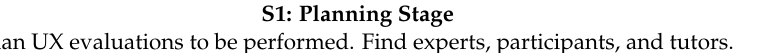
Table A1. Planning Stage